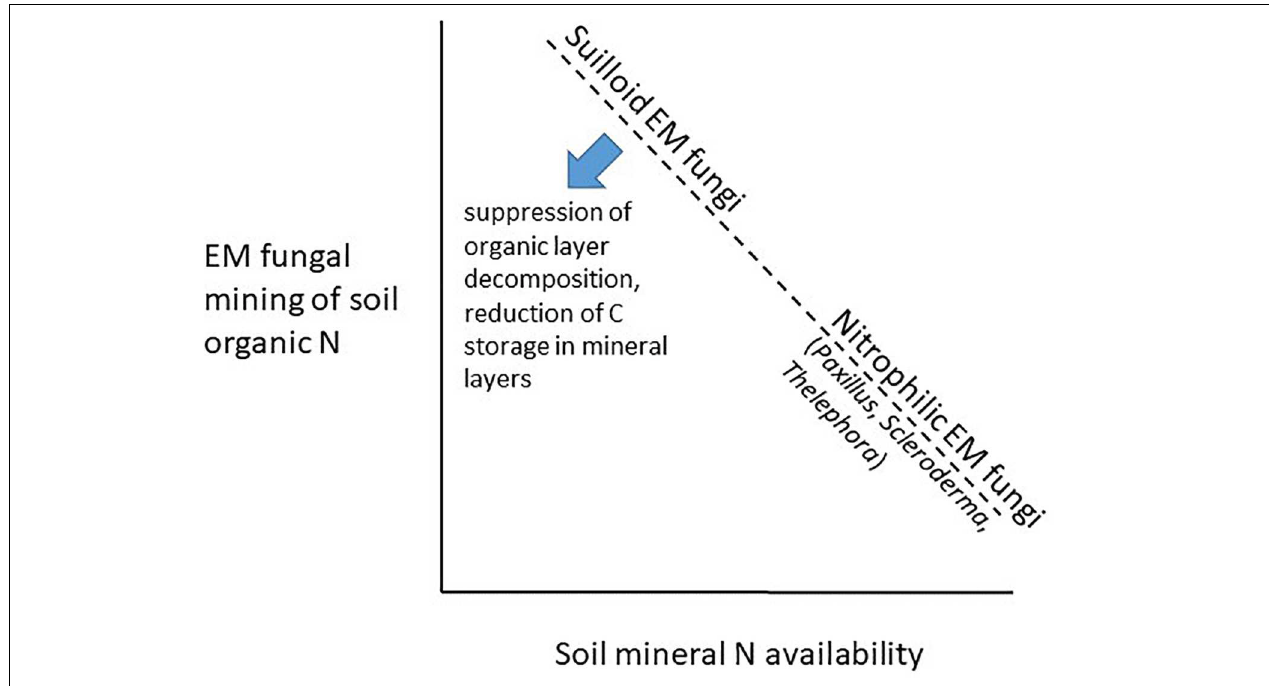
FIGURE 4 | Hypothesized trade-off between soil organic N decomposition capability (an effect trait) and tolerance to high soil mineral N (i.e., being “nitrophilic,” a “response trait”), resulting in stronger predicted “Gadgil effect” of EM fungal suppression of decomposition by free-living saprobes (in surface organic soil layers) at sites where Suilloid EM fungi are favored by conditions of low soil mineral N availability, along with reduced C storage in mineral layers due to reduced production of mineral protected microbial